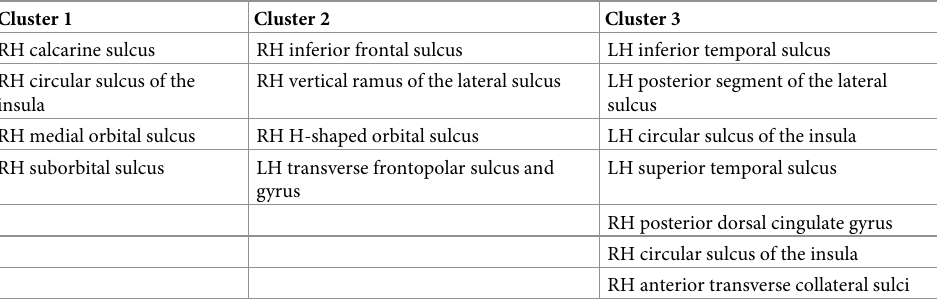
Table 4. Cortical thickness network hubs defined by node betweeness.